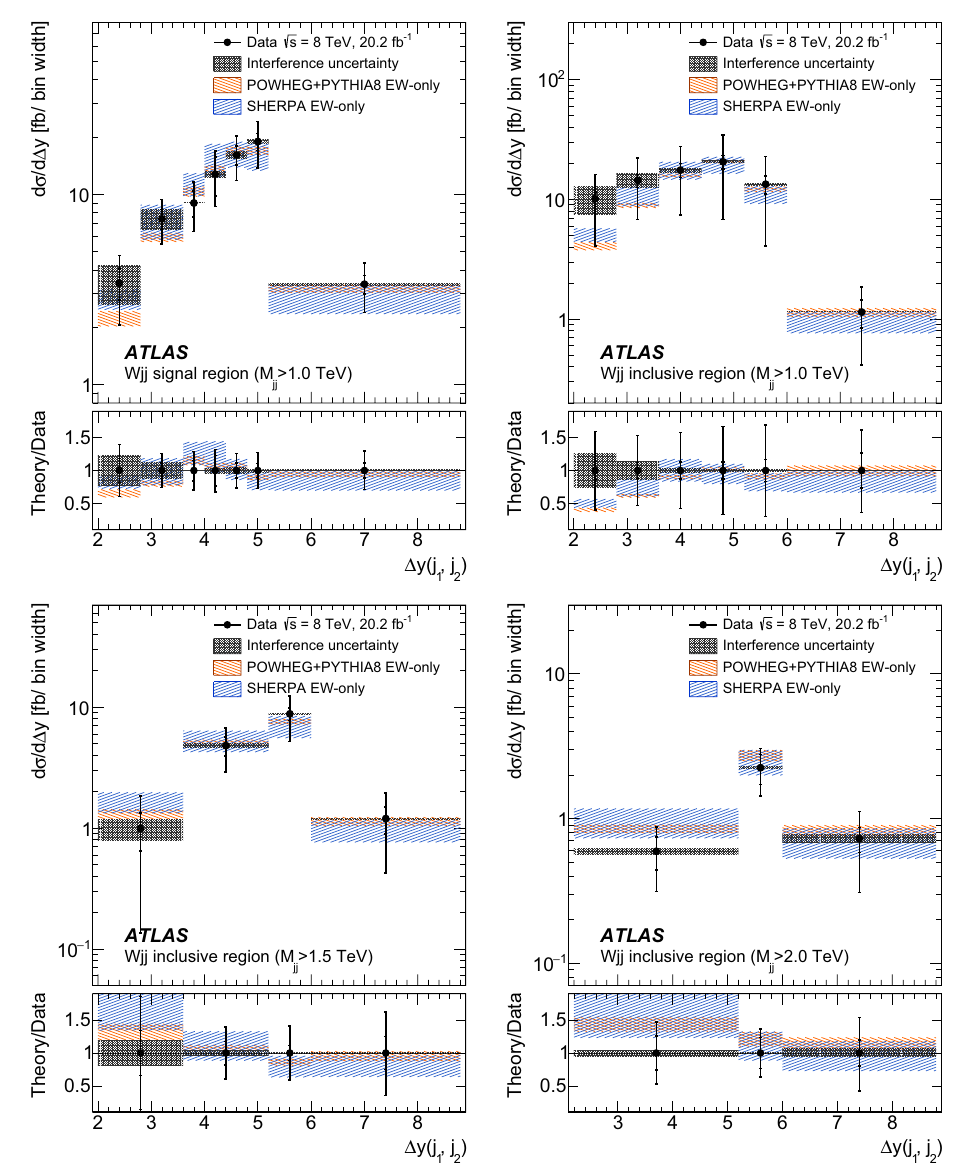
Fig. 34 Differential electroweak W jj production cross sections as a function of (cid:6) y ( j 1 , j 2 ) in the high-mass signal region and the inclusive fiducialregionwiththreethresholdsonthedijetinvariantmass(1.0,1.5,